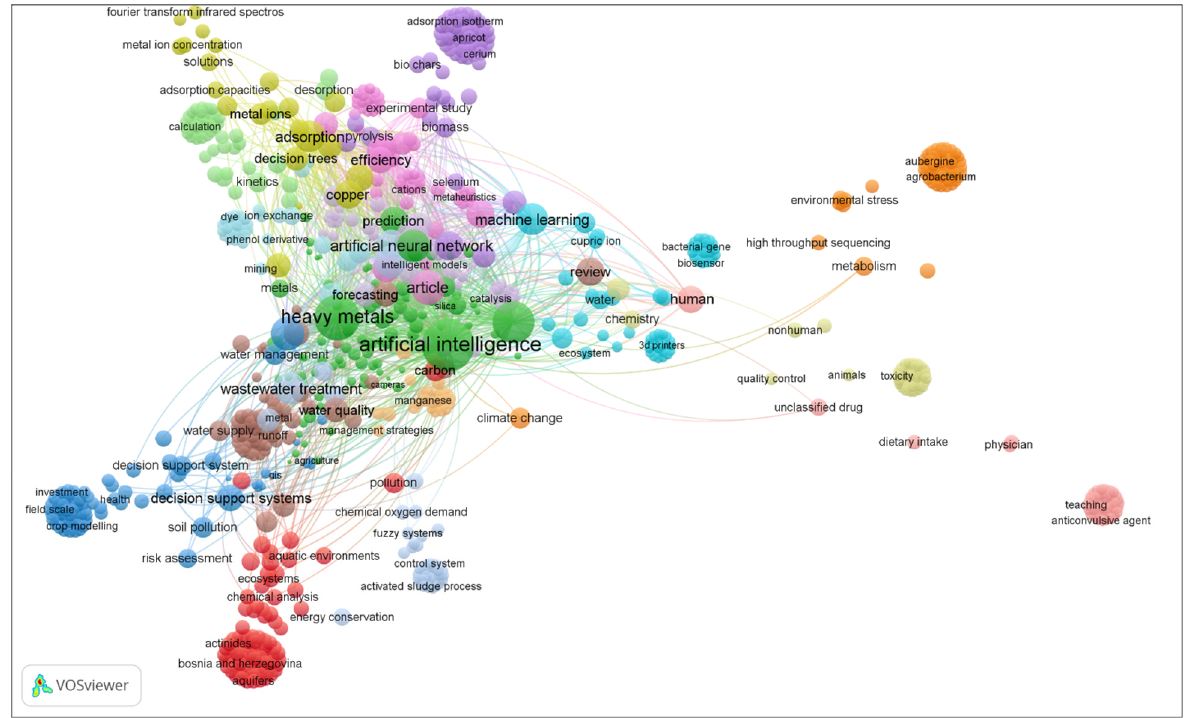
Figure 1. Major keywords used in AI technique analysis on HMs.